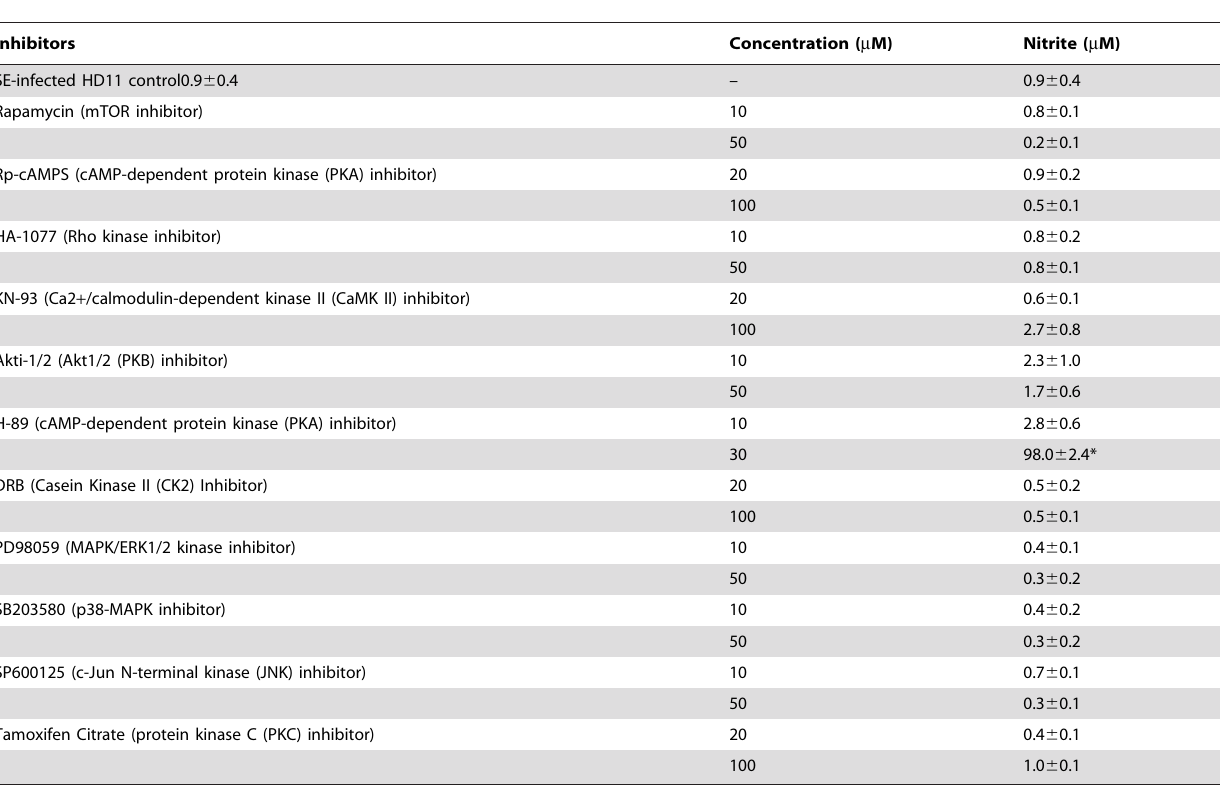
Table 1. Effect of kinase inhibitors on nitric oxide production in Salmonella-infected chicken macrophage HD-11 cells.